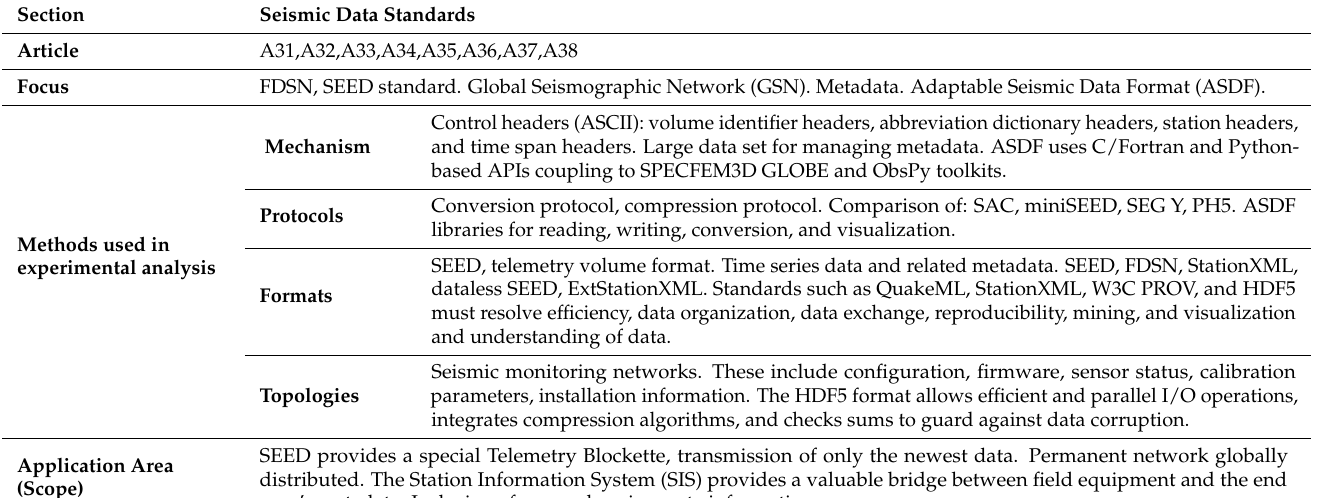
Table 6. Seismic Data